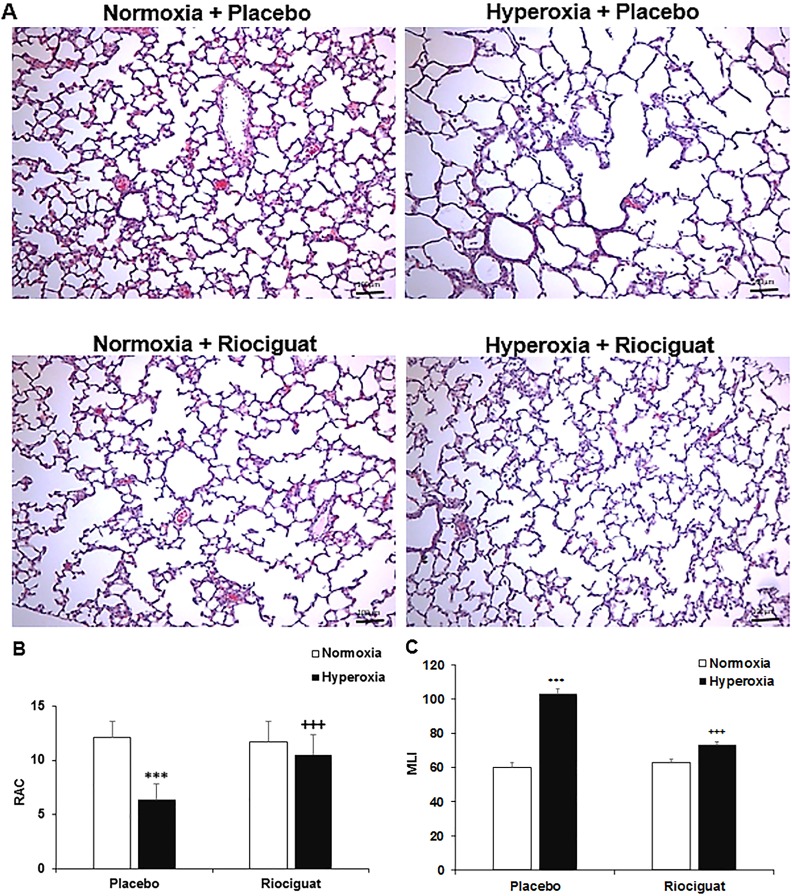
Riociguat prevents hyperoxia-impaired alveolarization.(A) H & E stained lung histology. Hyperoxia exposure in the presence of placebo decreased radial alveolar count (RAC) (B) and increased mean linear intercept (MLI) (C) as compared with normoxia. Administration of riociguat increased RAC and decreased MLI during hyperoxia. ***P < 0.001 compared with normoxia; +++P < 0.001 compared with hyperoxia + placebo (n = 6/group). Scale bar: 100 μm.